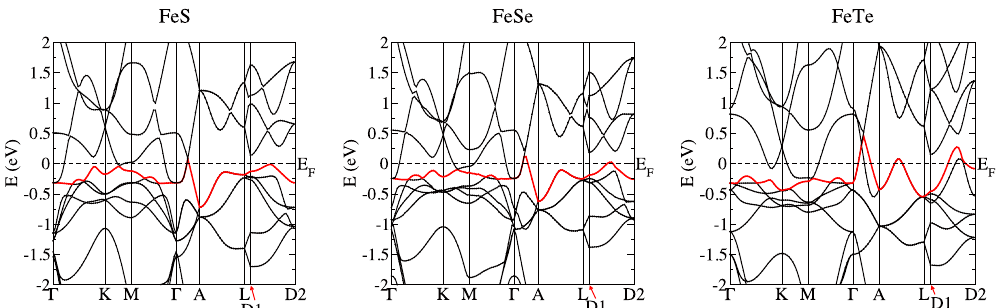
Figure 4. The calculated band structure plots for hexagonal FeS (left), FeSe (center) and FeTe (right). FeS band 20, and the corresponding FeSe and FeTe band 30, are shown in red. Except for D1 and D2, the notation is standard; D1 and D2 refer, respectively, to points 1/4 π / c below the L point (towards the basal plane), and a point this same distance below the A point at (0, 0, π / c ). Hence the line D1-D2 parallels the basal plane, and for FeS and FeSe the van Hove singularity can be seen touching the Fermi level approximately halfway between these points, and from the generally very small dispersions along this direction. For FeTe the dispersion in this area is much larger and the van Hove singularity does not cut the Fermi level, partly accounting for the decreased magnetic character of hexagonal